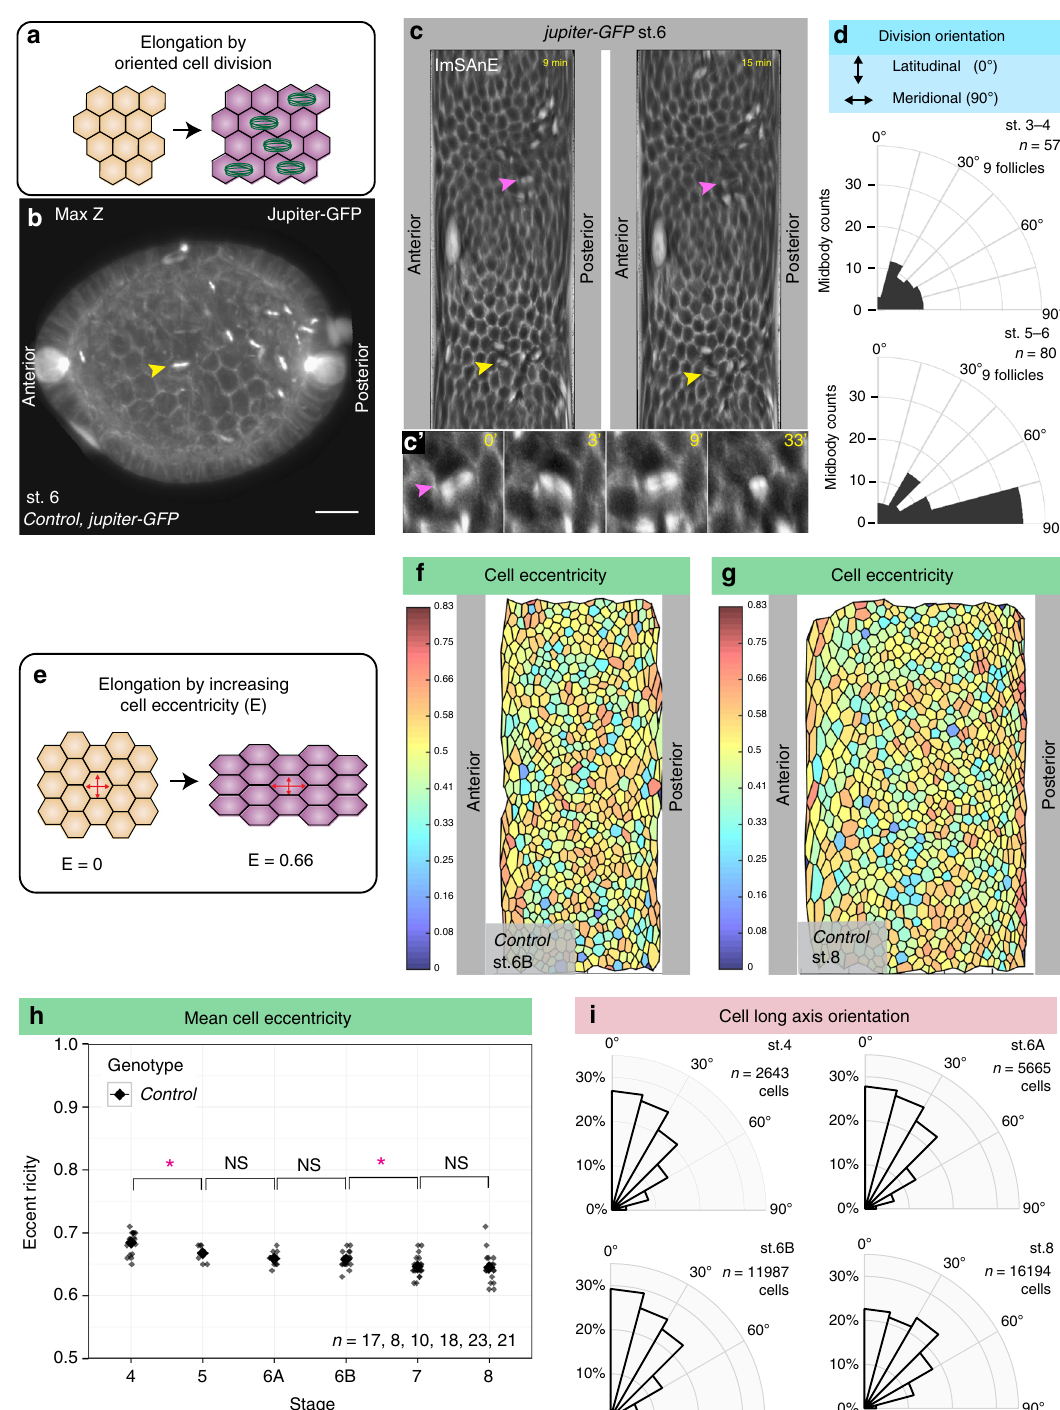
Fig. 3 Cell division orientation and cell eccentricity in elongating follicles a Schematic of tissue elongation via polarized cell division. b Maximum Z projection from confocal stacks of live-imaged follicle expressing Jupiter-GFP (gray) to mark mitotic spindles and midbodies. c ImSAnE cylinder projections of the same follicle. Yellow arrowheads mark the same cell division in ( b , c ). Magenta arrowhead in ( c , c ′ ) marks a cell division in which the spindle changes orientation (see also Supplementary Fig. 2b). d Quantitation of division orientation (0° = latitudinal; 90° = meridional) shows that cytokinetic angles are broadly distributed in round stage 3 – 4 follicles but become oriented along the AP arc in elongating stage 5 – 6 follicles. e Schematic of tissue elongation via increased cell eccentricity. f , g ImSAnE projections of stage 6B and stage 8 follicles, color-coded for eccentricity (0 = rounded; 0.83 = highly elongated). h Mean cell eccentricity changes modestly during stage 4 – 8, as compared to the strongly increased elongation of the organ overall. P values = 0.015, 0.17, 0.8, 0.017, and 0.77; two-sided Welch ’ s t test. i Orientation of cell eccentricity (0° = latitudinal; 90° = meridional) shows that most cells are elongated perpendicular to the AP axis. n , biologically independent samples. Error bars, s.e.m. NS not signi fi cant, *P < 0.5. Scale bar, 10 μ